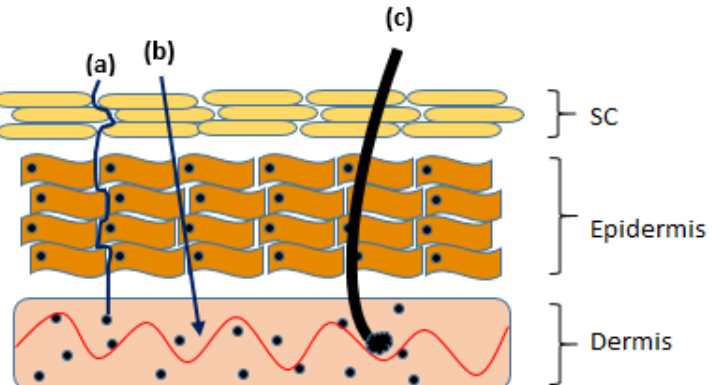
follicles and sweat